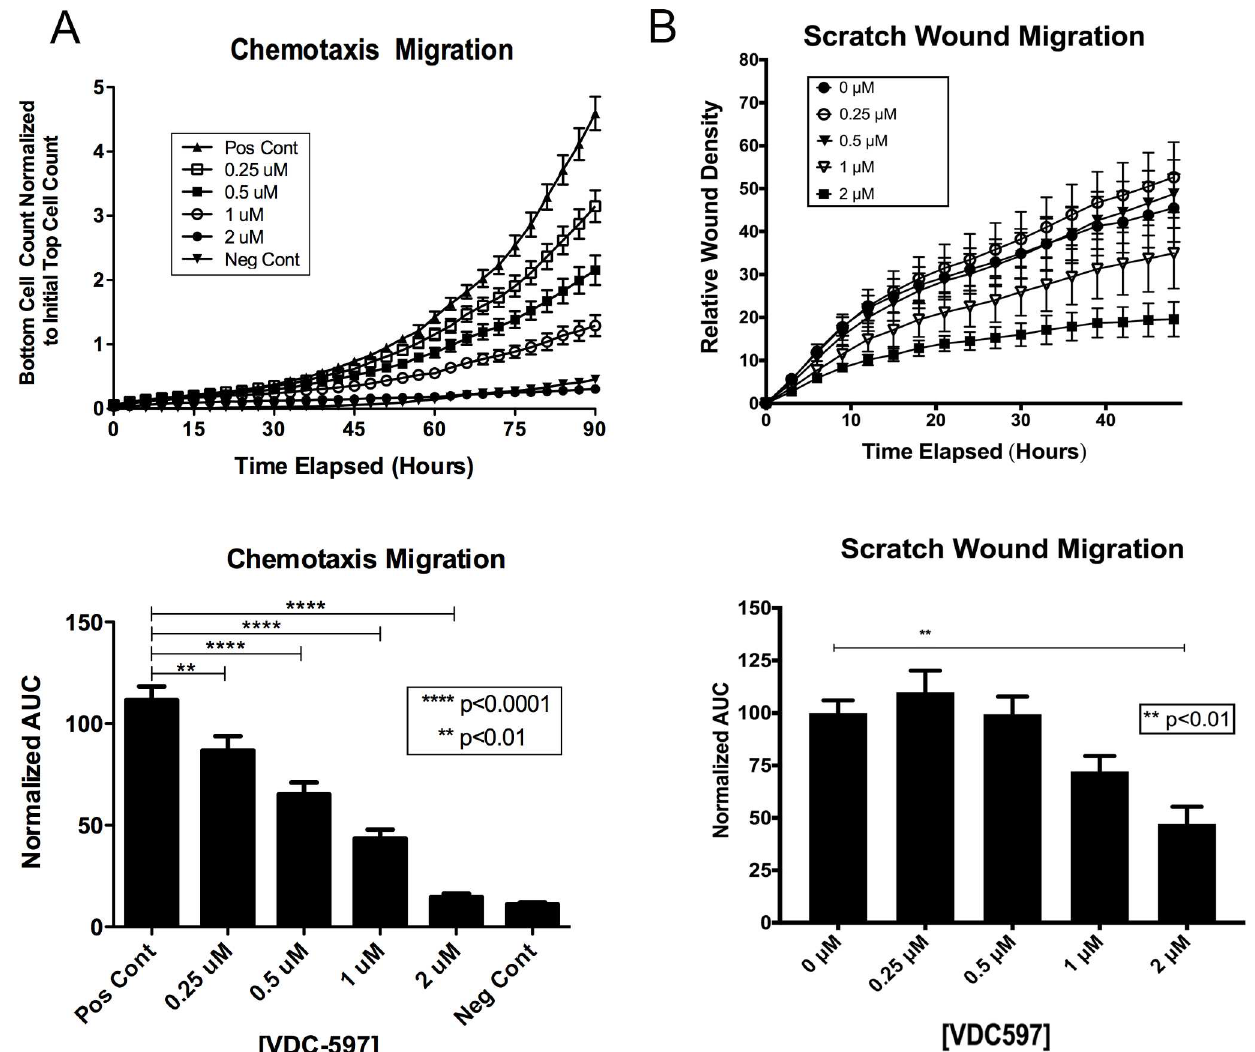
Fig 6. VDC-597 inhibits canine hemangiosarcoma cell migration. A. DEN-HSA was plated in the top chamber of a specialized 96-well chemotaxis migration plate in either C/0.1 EMEM or C/0.1 EMEM with various concentrations of VDC-597. C/20 EMEM or C/20 EMEM with identical various concentrations of VDC-597 of the top chamber was placed in the bottom chamber. Migration of the cells through the micropore membrane was assessed using the Incucyte Live Cell Imaging System over 90 hours. Area under the curve for each condition is expressed. Asterisks indicate P values less than 0.05. B. DEN-HSA was plated and allowed to grow to confluency in a specialized 96-well scratch wound assay plate. A uniform defect (“scratch”) was made through the confluent layer of cells and mitomycin C-containing C/10 EMEM with various concentrations of VDC-597 was added. Relative wound density was assessed using the Incucyte Live Imaging System over 48 hours. Area under the curve for each condition is expressed. Asterisks indicate P values less than 0.05. Error bars indicate standard error measurements.